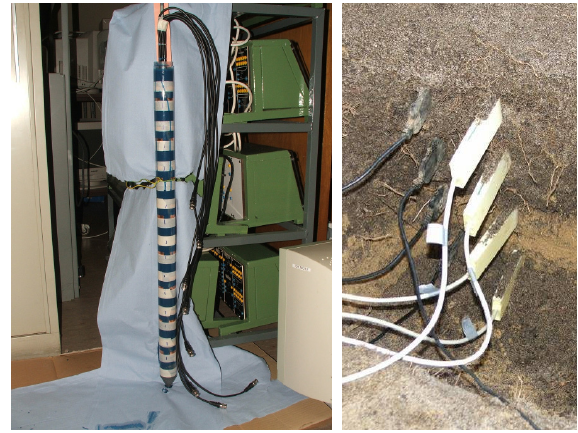
Figure 1. Two types of humidity sensors.